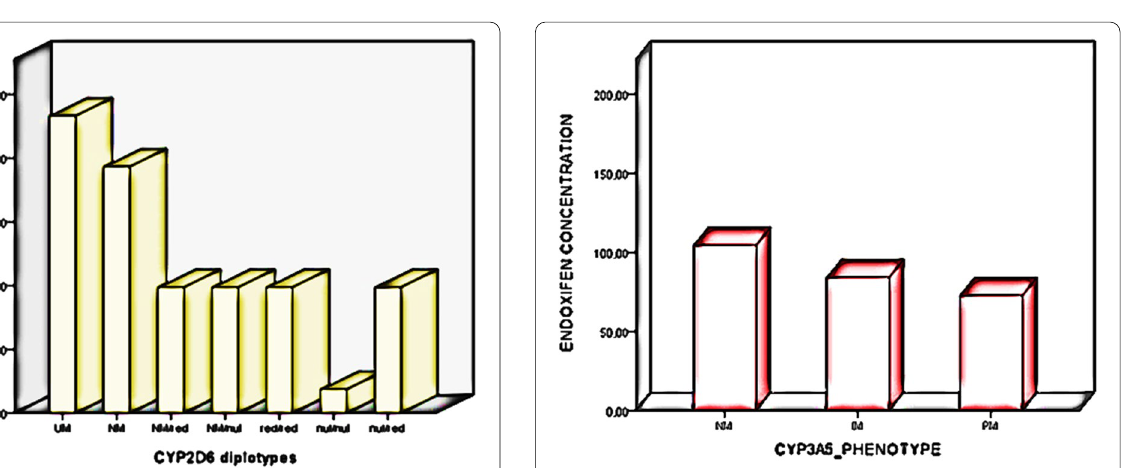
Fig. 3 Plasma Endoxifen concentrations in women with estrogen receptor-positive breast cancer in relation to major groups of CYP2D6 diplotypes with regards to the combination of fully functional NM, reduced activity (red) and nul allele